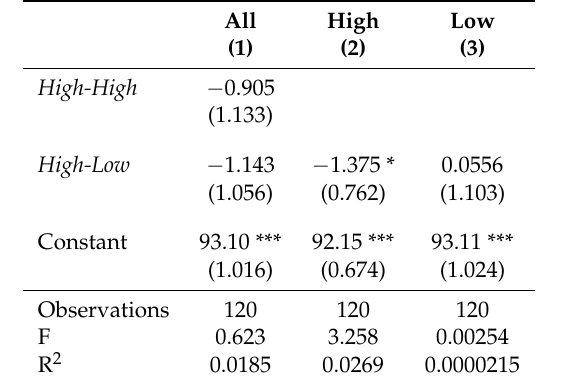
Table A7. Linear regressions: average group payoff in Part B—merged group treatment